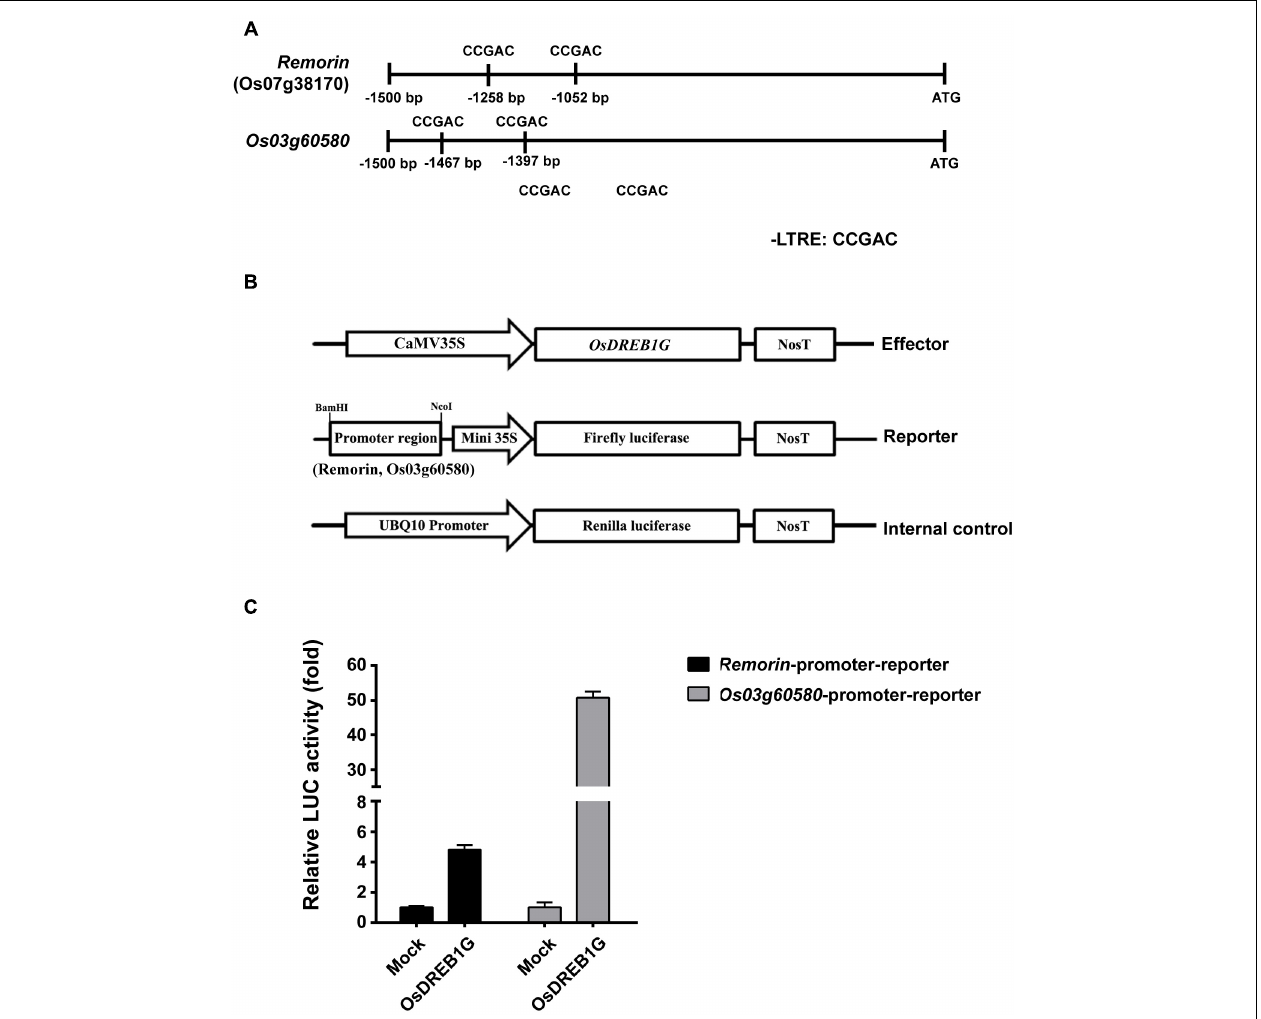
FIGURE 5 | Transactivation of cold-inducible promoter-luciferase fusion genes by OsDREB1G. (A) Promoter analysis of the target genes Remorin and Os03g60580 . ATG indicates transcription start site. Putative CRT/DRE motifs are indicated in each promoter region. (B) Schematic diagram of the effector and reporter constructs used for co-transfection. (C) OsDREB1G was transfected with each promoter-fLUC reporter plasmid and UBQ10-rLUC plasmid as an internal control into rice protoplasts by PEG transfection. Error bars indicate standard errors. The experiments were performed with at least three biological